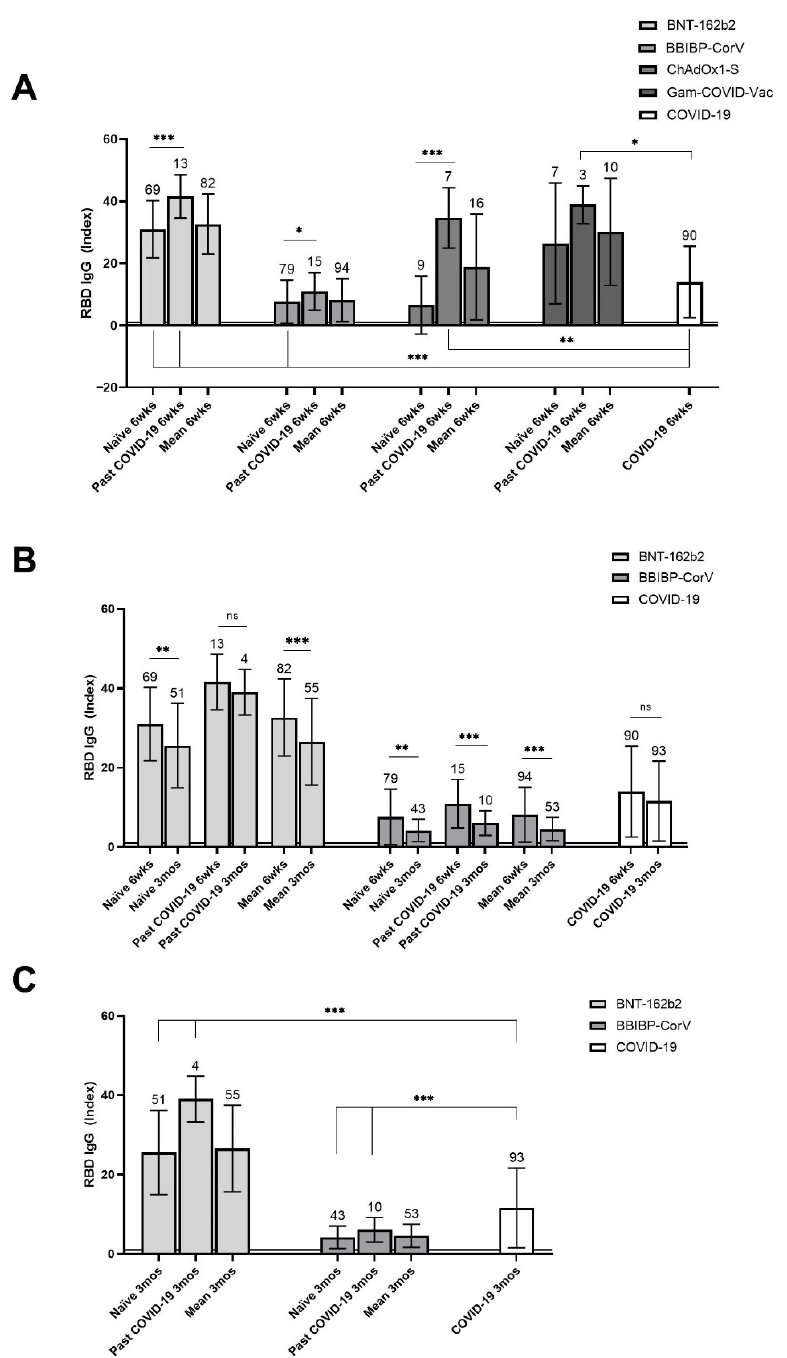
Figure 2. Mean levels of SARS-CoV-2 spike protein RBD-specific IgG antibodies post vaccination according to pre-vaccinal COVID-19 status, and post infection. ( A )—in recipients of BNT-162b2, BBIBP-CorV, ChAdOx1-S, and Gam-COVID-Vac vaccines at 6 weeks post vaccination, as compared with non-vaccinated individuals with past COVID-19 at 6 weeks post infection. ( B )—kinetics of antibody levels in recipients of BNT-162b2 and BBIBP-CorV from 6 weeks to 3 months post- vaccination, and in non-vaccinated individuals with past COVID-19 from 6 weeks to 3 months post infection. ( C )—in recipients of BNT-162b2 and BBIBP-CorV at 3 months post vaccination, as compared with non-vaccinated individuals with past COVID-19 at 3 months post infection. ( A – C )—Sample sizes are shown above standard deviation (SD) error bars. Horizontal line at an index of 1 indicates test cut-off. * p ≤ 0.05; ** p ≤ 0.01; *** p ≤ 0.001; ns—non-significant; wks—weeks;